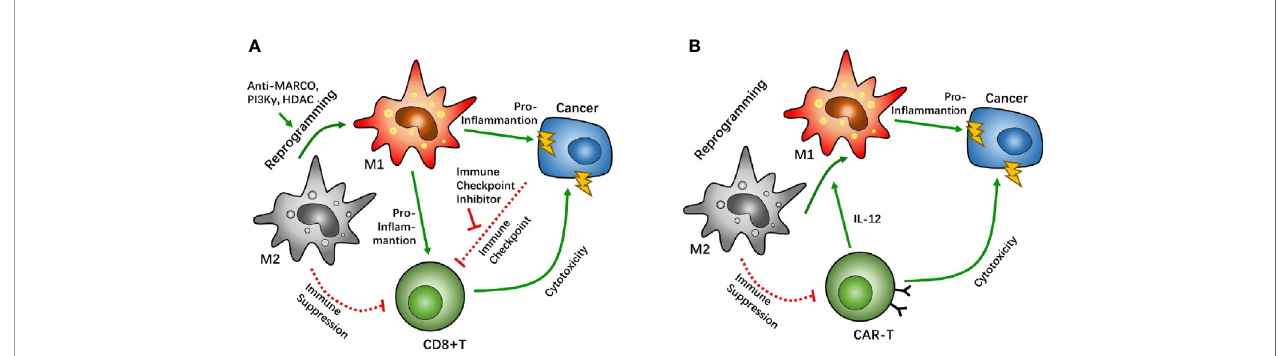
FIGURE 3 | Macrophage reprogramming as a potential target between tumor associated macrophages (TAMs) and CD8-positive (CD8+) T cells. Macrophage reprogramming of TAMs can help shift the microenvironment from an immunosuppressive phenotype to a pro-in fl ammatory phenotype. In immune checkpoint therapy, macrophage receptors with a collagenous structure (MARCO), phosphoinositide 3-kinase g (PI3K g ), and histone deacetylase have been proven as targets that enhance the ef fi cacy of immune checkpoint inhibitors through macrophage reprogramming (A). In chimeric antigen receptor T cell (CAR-T) therapy, CAR-T cells can reprogram TAMs by overexpressing IL-12 to boost its cytotoxicity